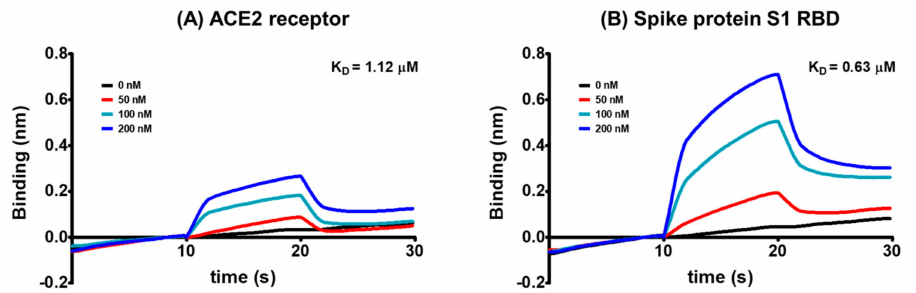
Figure 2. The global kinetic analysis of geraniin binding to biotinylated ( A ) hACE2 receptor and ( B ) spike protein S1 RBD immobilized on a streptavidin-coated sensor. The kinetics of geraniin for the spike protein or hACE2 receptor was measured by associating 0, 50, 100, and 200 nM of geraniin in PBS containing 1% DMSO with immobilized spike protein or hACE2 receptor and then dissociating in a blank